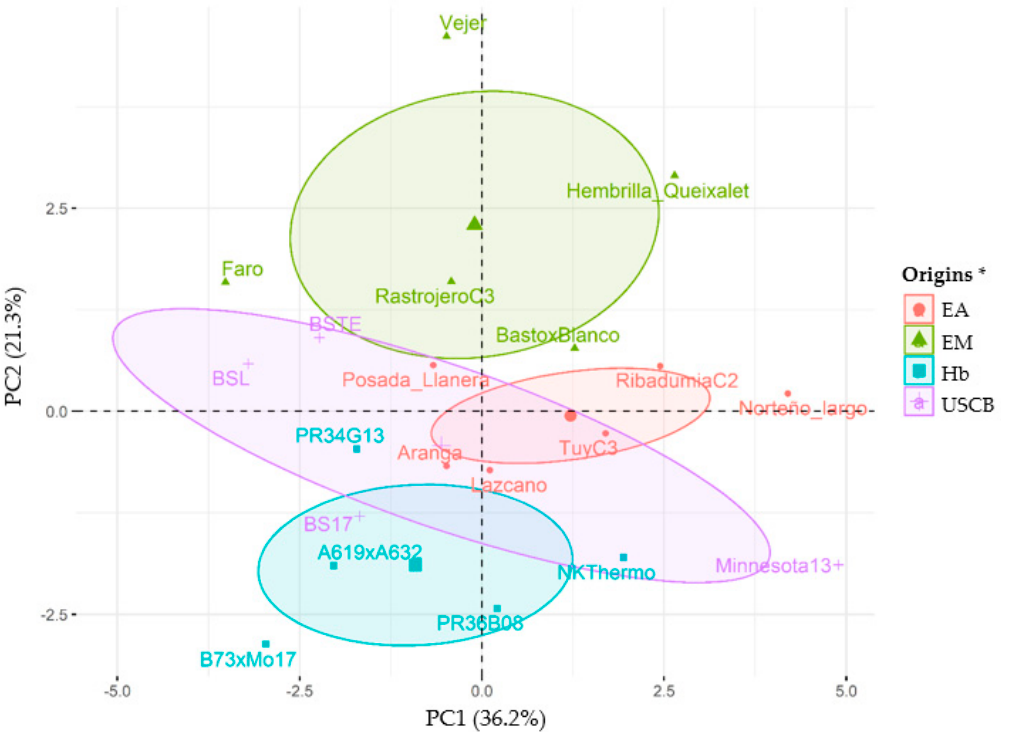
Figure 3. Plot of principal components analysis (PCA) of component 1 (PC1) versus 2 (PC2) across origins described in Table 2, with the genotypes grown across four environments in 2010 and 2011 in Pontevedra, Spain. * Europe Atlantic = EA, Europe Mediterranean = EM, US Corn Belt = USCB, and hybrid = Hb.